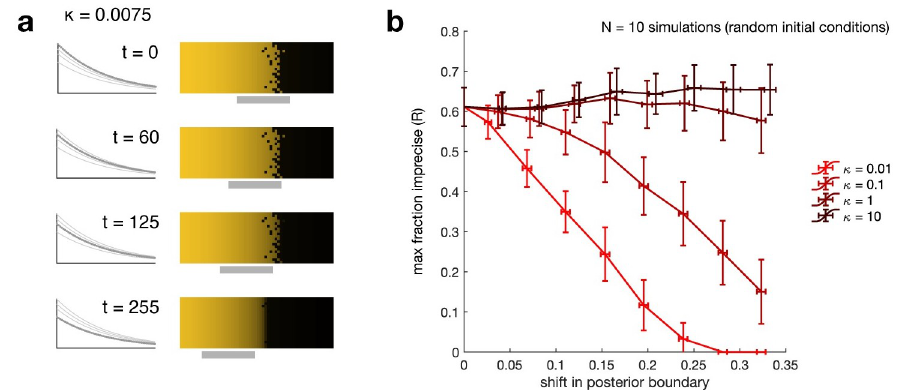
Fig 3. (a) Temporal decrease in the morphogen concentration at every point in space can “sweep away” imprecision in the expression boundary . Decrease in morphogen concentration causes the bistable region (solid gray line) to shift anteriorly over time. Thus, cells to the anterior are initially monostable for high u � they become bistable, whereas cells in the initially bistable region become monostable for high u � conditions here are derived from the steady-state solution to a system with a static gradient equivalent to that of the dynamic gradient at t = 0; see Fig 2 with κ = 1 . (b) Slower gradient dynamics are more effective at increasing precision . Lines are mean, error bars are standard deviation across N = 10 simulations with different initial conditions at different values of κ (light to dark red), the ratio between rate of gradient decay and rate of convergence to steady state. R quantifies the maximum width of the imprecise region relative to the width of the bistable region at the time t by which the boundary has shifted by a fixed amount from its initial location. Lower R corresponds to greater precision (see text). Slower-decaying gradients produce more precise boundaries for the same total shift than do faster-decaying gradients, but take longer to achieve these